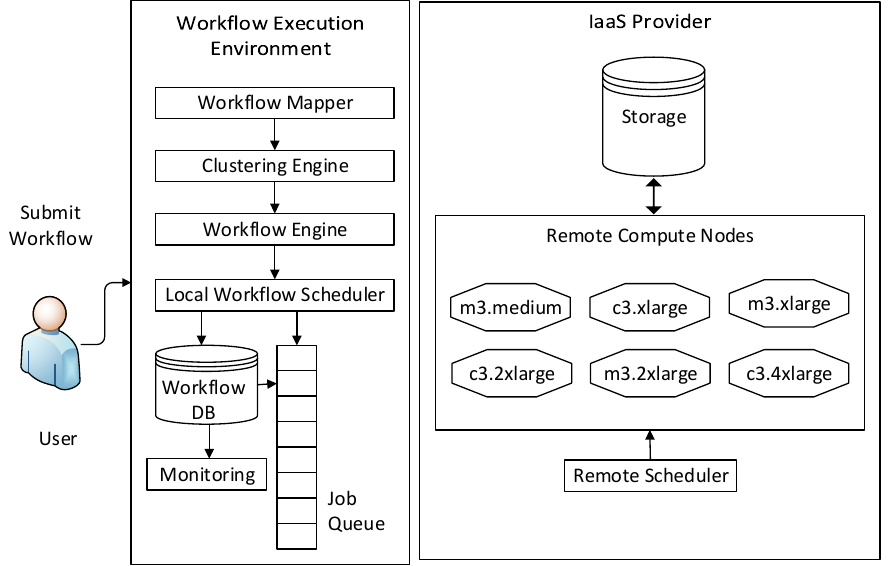
Figure 1. A workflow system architecture. DB: Database